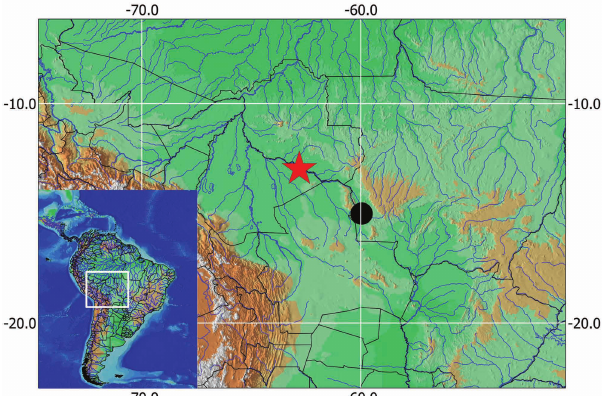
Fig. 6. Map showing geographic distribution of Corydoras guapore . Red star represents the approximate type-locality, rio Guaporé, Rondônia State, and the black circle represents the more recent record of the species, rio Guaporé, Mato Grosso State.